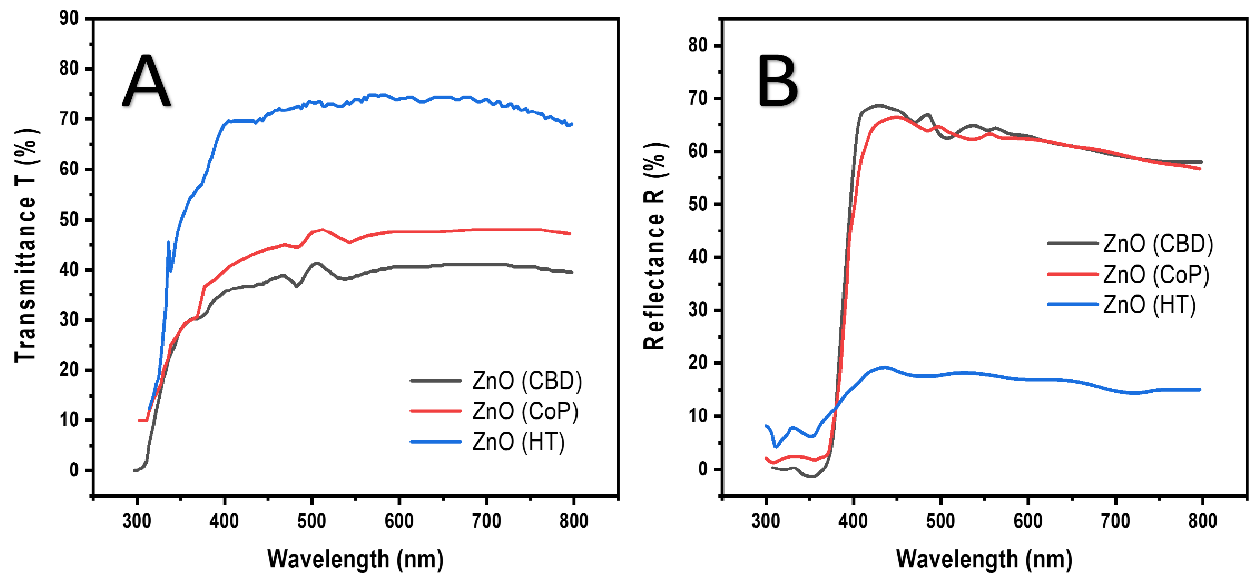
Figure 3. ( A ) Percent Transmittance (T%) and ( B ) Percent Reflectance (R%) spectra of ZnO grown by various techniques.